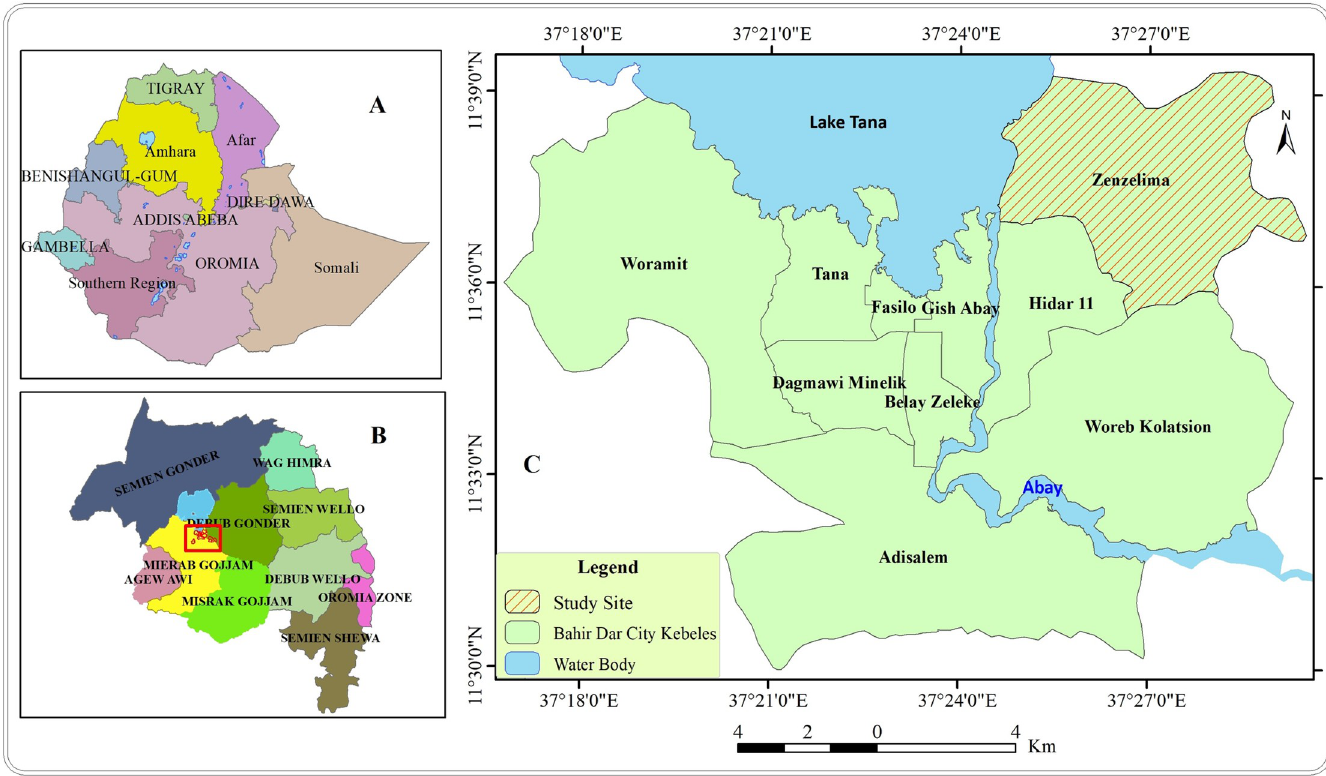
Fig 1. Location of the study site, Zenzelima: (A) Map of Ethiopia, (B) Map of Amhara region, (C)